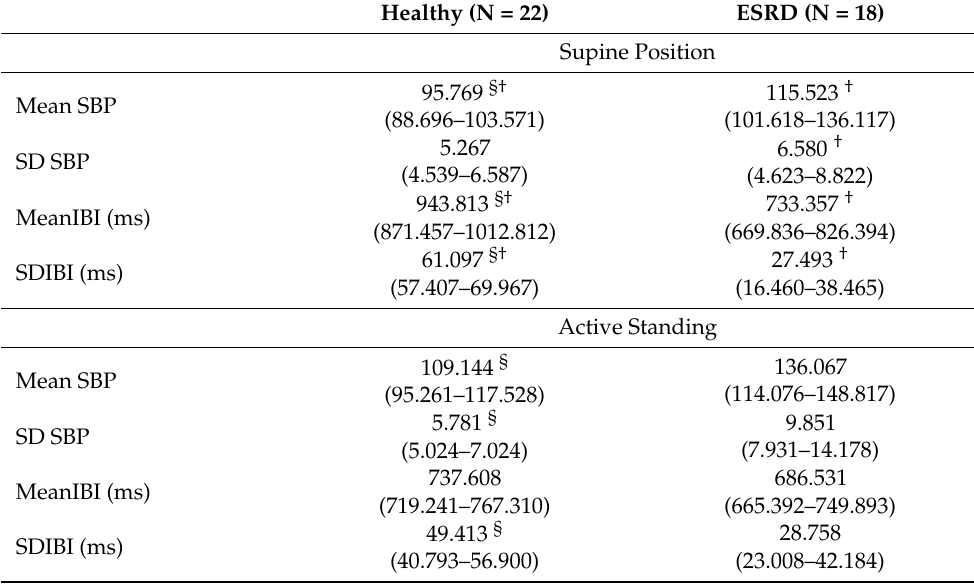
Table 2. Systolic blood pressure (SBP) variability and heart rate variability indices obtained from IBI time series. Data shown as median (interquartile